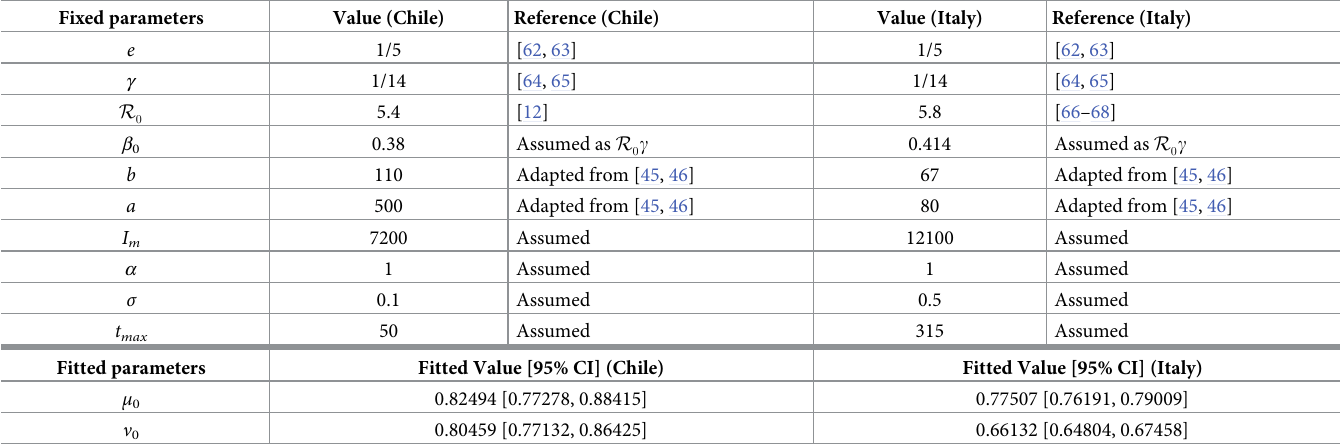
Table 3. Parameters for the simulations in Figs 7 and 8 for the case of Chile and Italy respectively. Fixed parameters Value (Chile) Reference